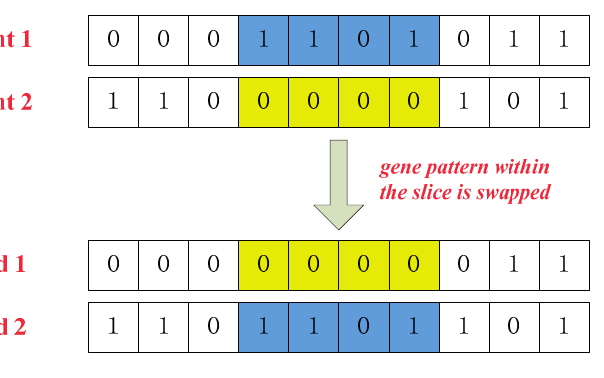
Figure 4. Crossover operation.